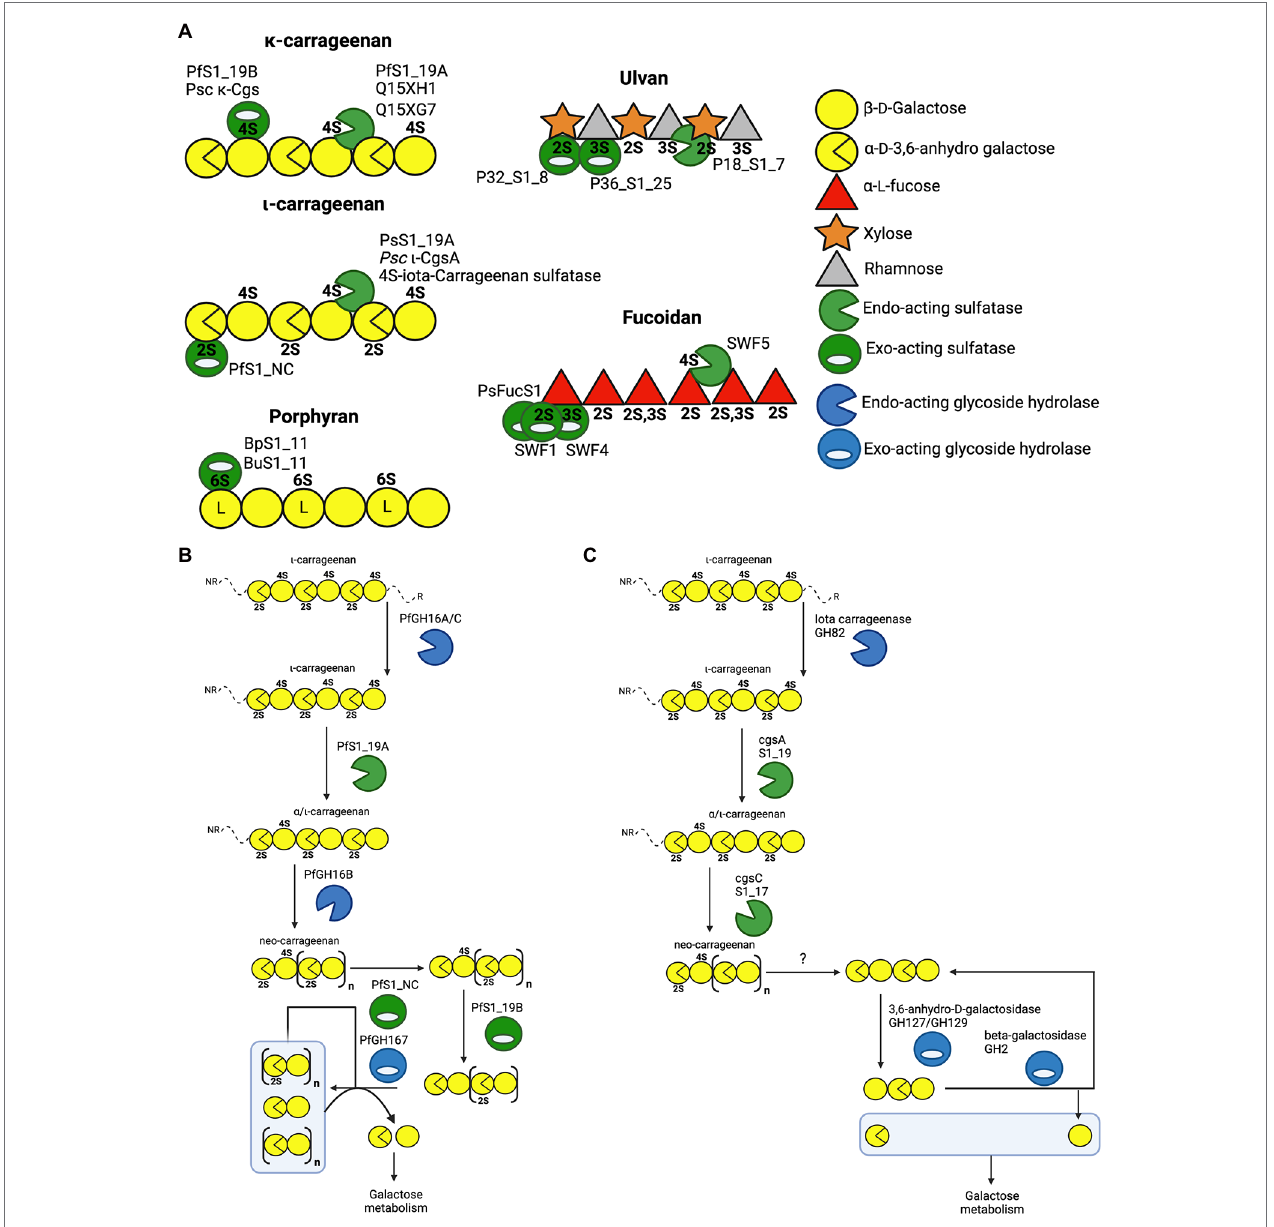
FIGURE 3 | Schematics of characterised sulfatases, substrates and enzyme cascades. (A) Schematic of characterised marine polysaccharide sulfatases and their substrates where preferred substrate and mode of action are confirmed. The iota and kappa classes of carrageenan are provided along with porphyran as well as the highest sulphation state of fucoidan and ulvan. Characterised sulfatases are positioned at the specific sulphate ester that they have been shown to hydrolyse. (B) Enzyme cascade for ɩ -carrageenan catabolism in Pseudoalteromonas fuliginea PS47. (C) Enzyme cascade for ɩ -carrageenan catabolism in Zobellia